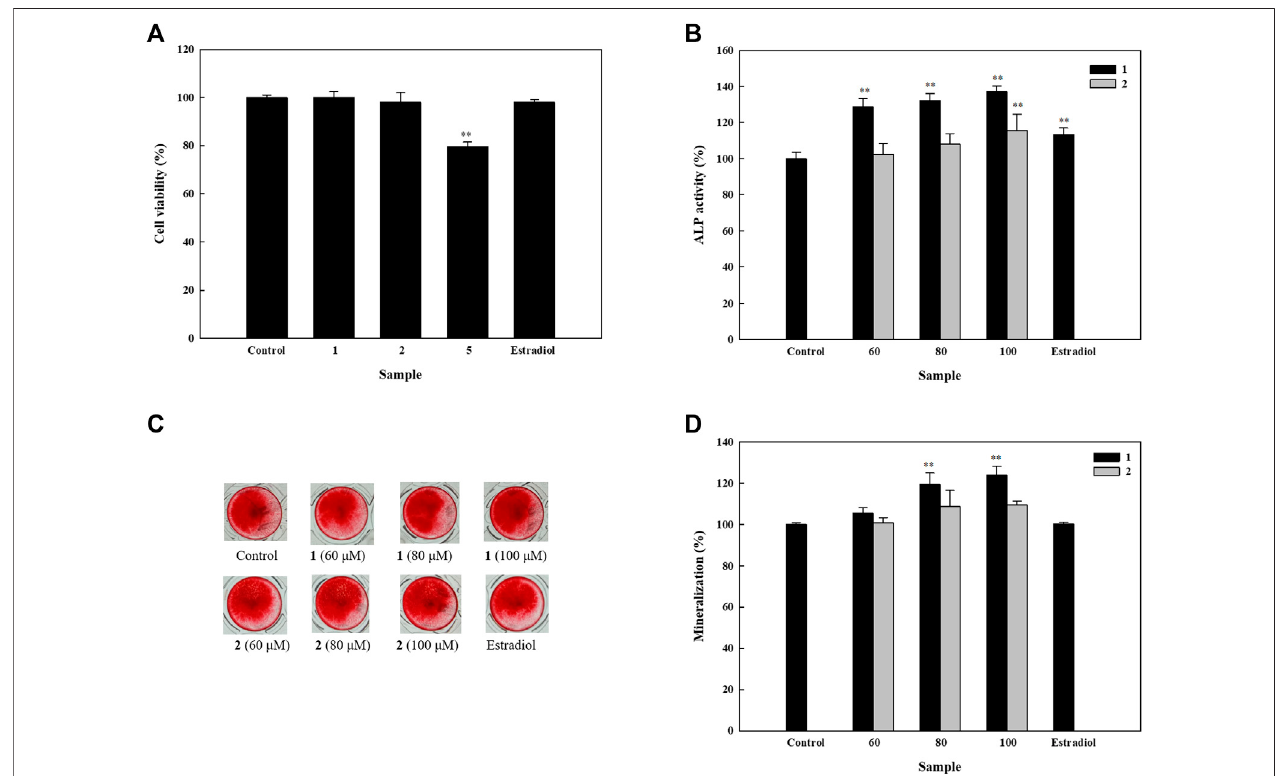
FIGURE 3 | Effects of isolated compounds on cell viability, alkaline phosphatase (ALP) activity, and mineralization in human osteoblast cells. Cells were seeded on 96-well plates for (A) cell viability and (B) ALP activity assays. Samples were added after 24 h of seeding, which was followed by performing detection assays after 5 days. To assess mineralization, cells were seeded in 48-well plates, and after 4 days, drugs were added alternatively using osteoblast differentiation medium and enhancers. An alizarin red S assay was performed after 11 days. (C) Detection of mineral deposition after using alizarin red S stain. (D) Quanti fi cation of mineral deposition. Experiments were carried out in triplicate. * p < 0.05 and ** p < 0.01; data are presented as the mean ± standard deviation. 1 , astragalin; 2 , kaempferol 3- O - β - D -apiofuranosyl-(1 → 6)- β - D -glucopyranoside; and 5 , 2,5-dimethoxy-3- O - β - D -glucopyranosyl cinnamic alcohol.